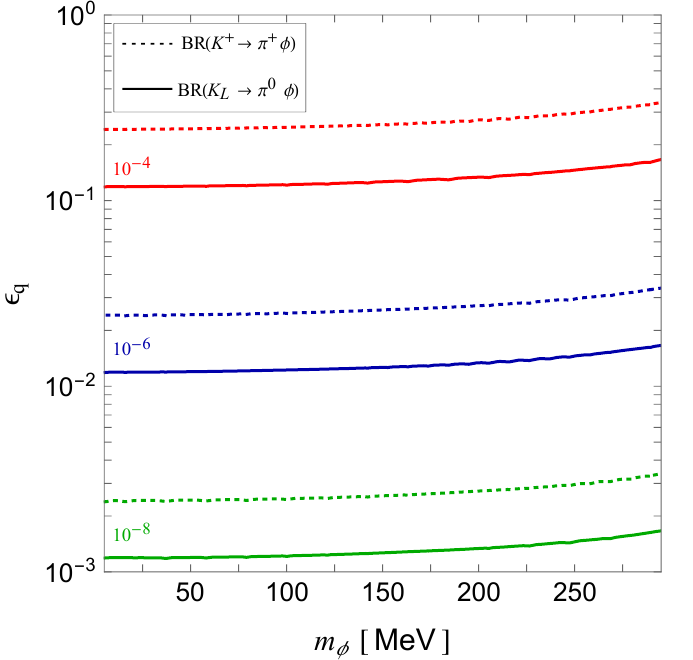
Figure 1 . Contours for BR( K L ! (cid:25) 0 (cid:30) ) and BR( K + ! (cid:25) + (cid:30) ) in the (cid:15) q { m (cid:30) plane. The solid colored lines indicate the contours for BR( K L ! (cid:25) 0 (cid:30) ). Dotted lines of corresponding colors